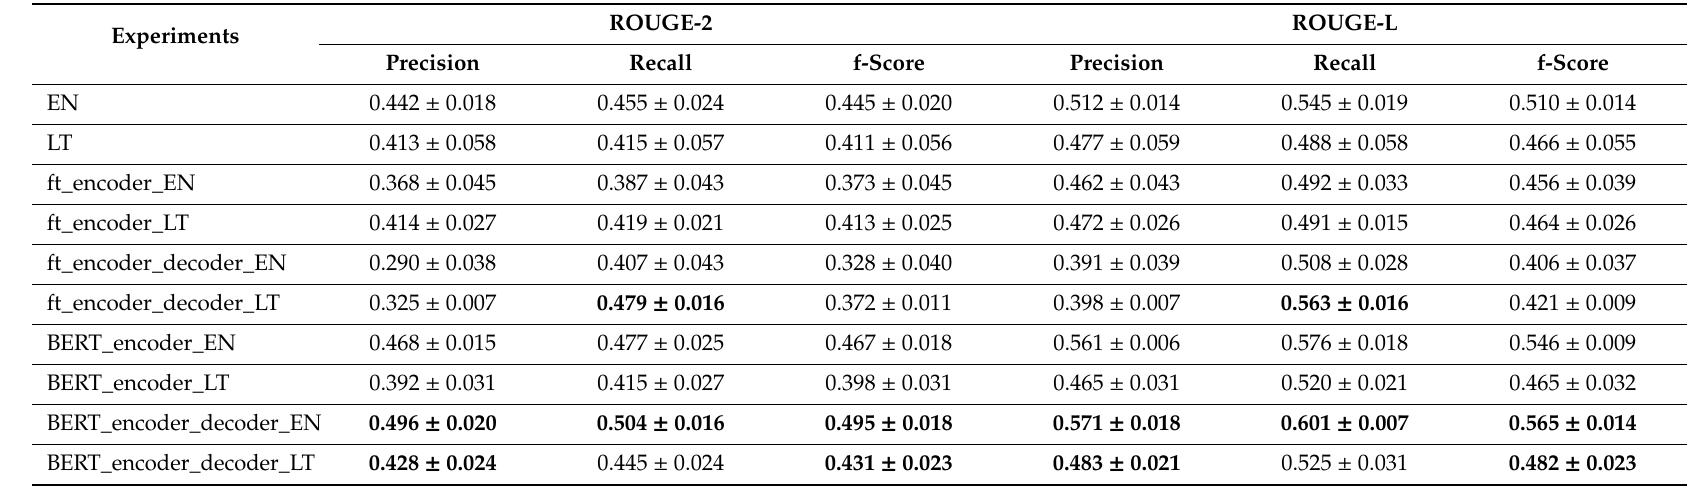
Table 6. Averaged ROUGE-2 and ROUGE-L precision / recall / f-score values with confidence intervals using the BiLSTM encoder and LSTM decoder model with di ff erent vectorization types on the dataset with removed punctuation. The best values in the column for EN and LT are in